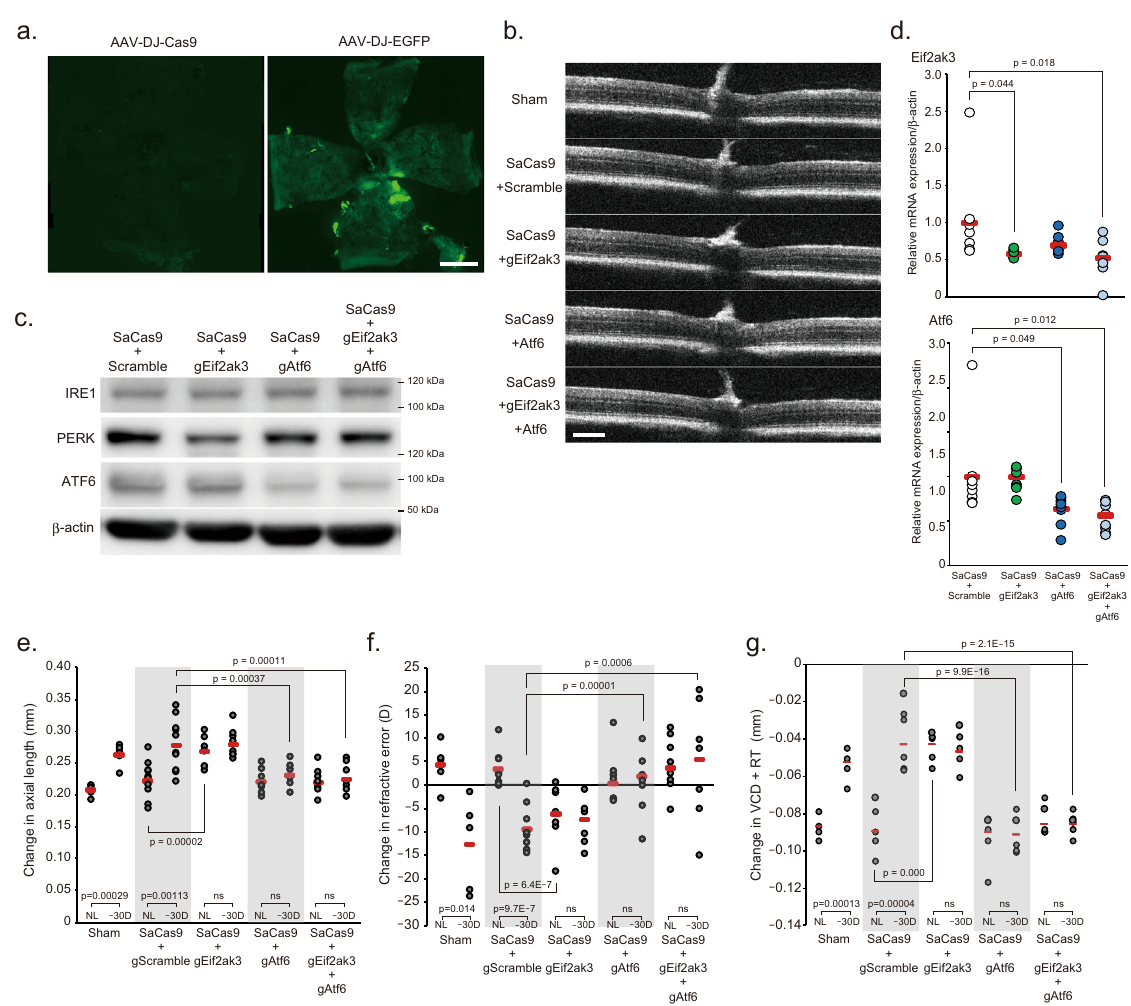
Fig. 6 | Effect of AAV-based gene knockdown of PERK and ATF6 in sclera on myopia development. a Distribution of EGFP expression in the scleral whole- mount 28 days after sub-tenon ’ s capsule injection of adeno-associated virus ser- otypeDJ(AAV-DJ)-EGFPor AAV-DJ-SaCas9 (as non- fl uorescencecontrol); scale bar, 1mm. b Representative Optical Coherence Tomography images 28 days after of each AAV injection; scale bar, 100 µ m. c Expression level of IRE1, PERK, and ATF6 protein 28 days after of AAV-SaCas9 with AAV-gRNA against Eif2ak3 (Gene symbol of PERK, gEig2ak3) and/or Atf6 (gAtf6) injections. d Scleral Eif2ak3 and Atf6 knockdown by AAV-DJ-CRISPR/Cas9 injection into sub-tenon ’ capsule. After 28 days injection, gene expression in the sclera determined by qPCR ( n =9, respectively). SaCas9 + gScramble group was assigned a value of 1.0. The p values were determined by one-way ANOVA with Tukey HSD. e Effects of scleral Eif2ak 3 and/or Atf6 knockdown on axial elongation (sham: n =5, gScramble: n =11,